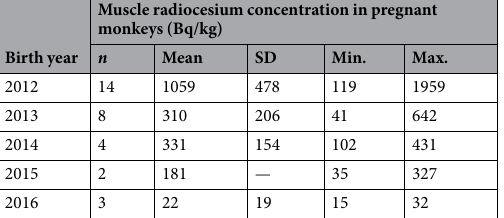
Table 1. Muscle radiocesium concentration in pregnant Japanese monkeys according to birth year.